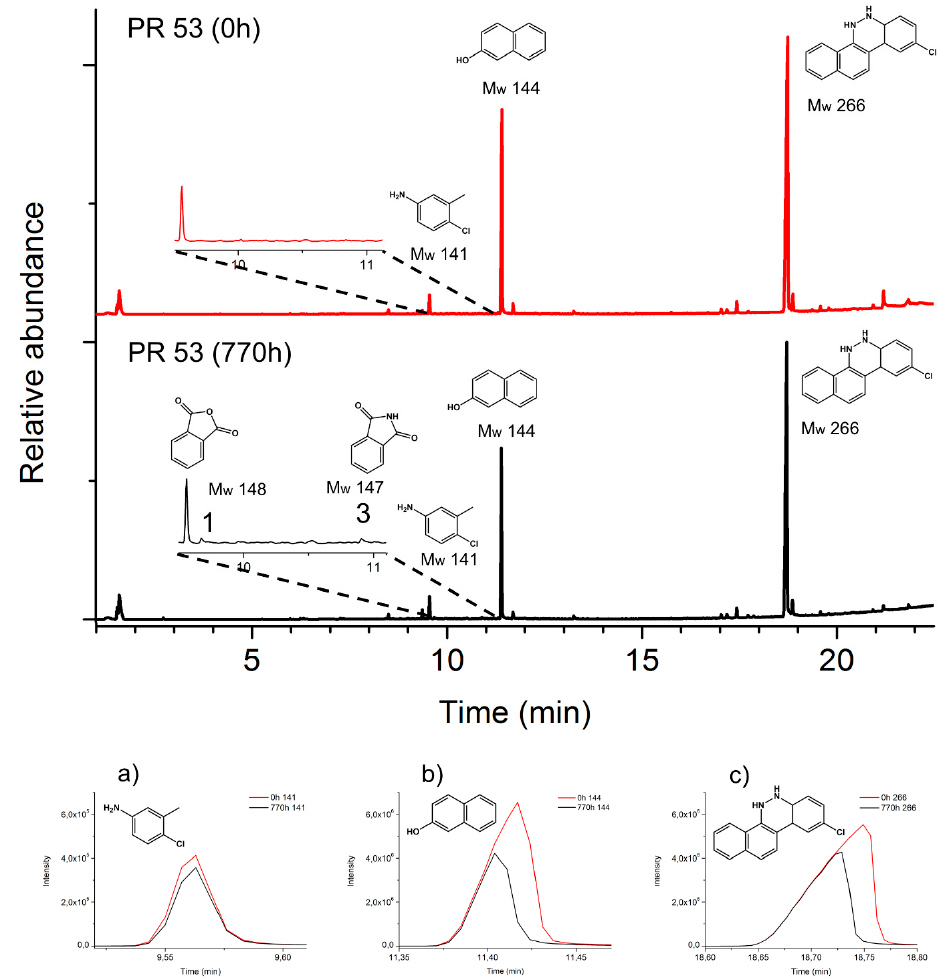
Figure 7. Top: normalized pyrograms of the red powder pigment PR 53:1. At 0 h, the main pyrolysis structures (M w 141, M w 144, and M w 266) are observed; after aging (770 h), decay products (M w 148 and M w 147) are formed (Table 1). Bottom ( a – c ): principal extracted ions (base peaks) of the main pyrolysis products.